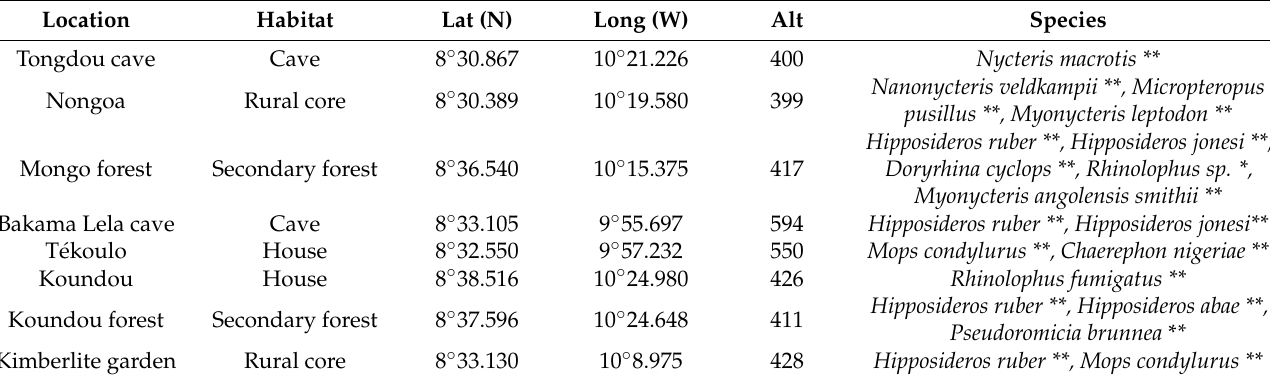
Table 1. Mist netting coordinates and species captured.